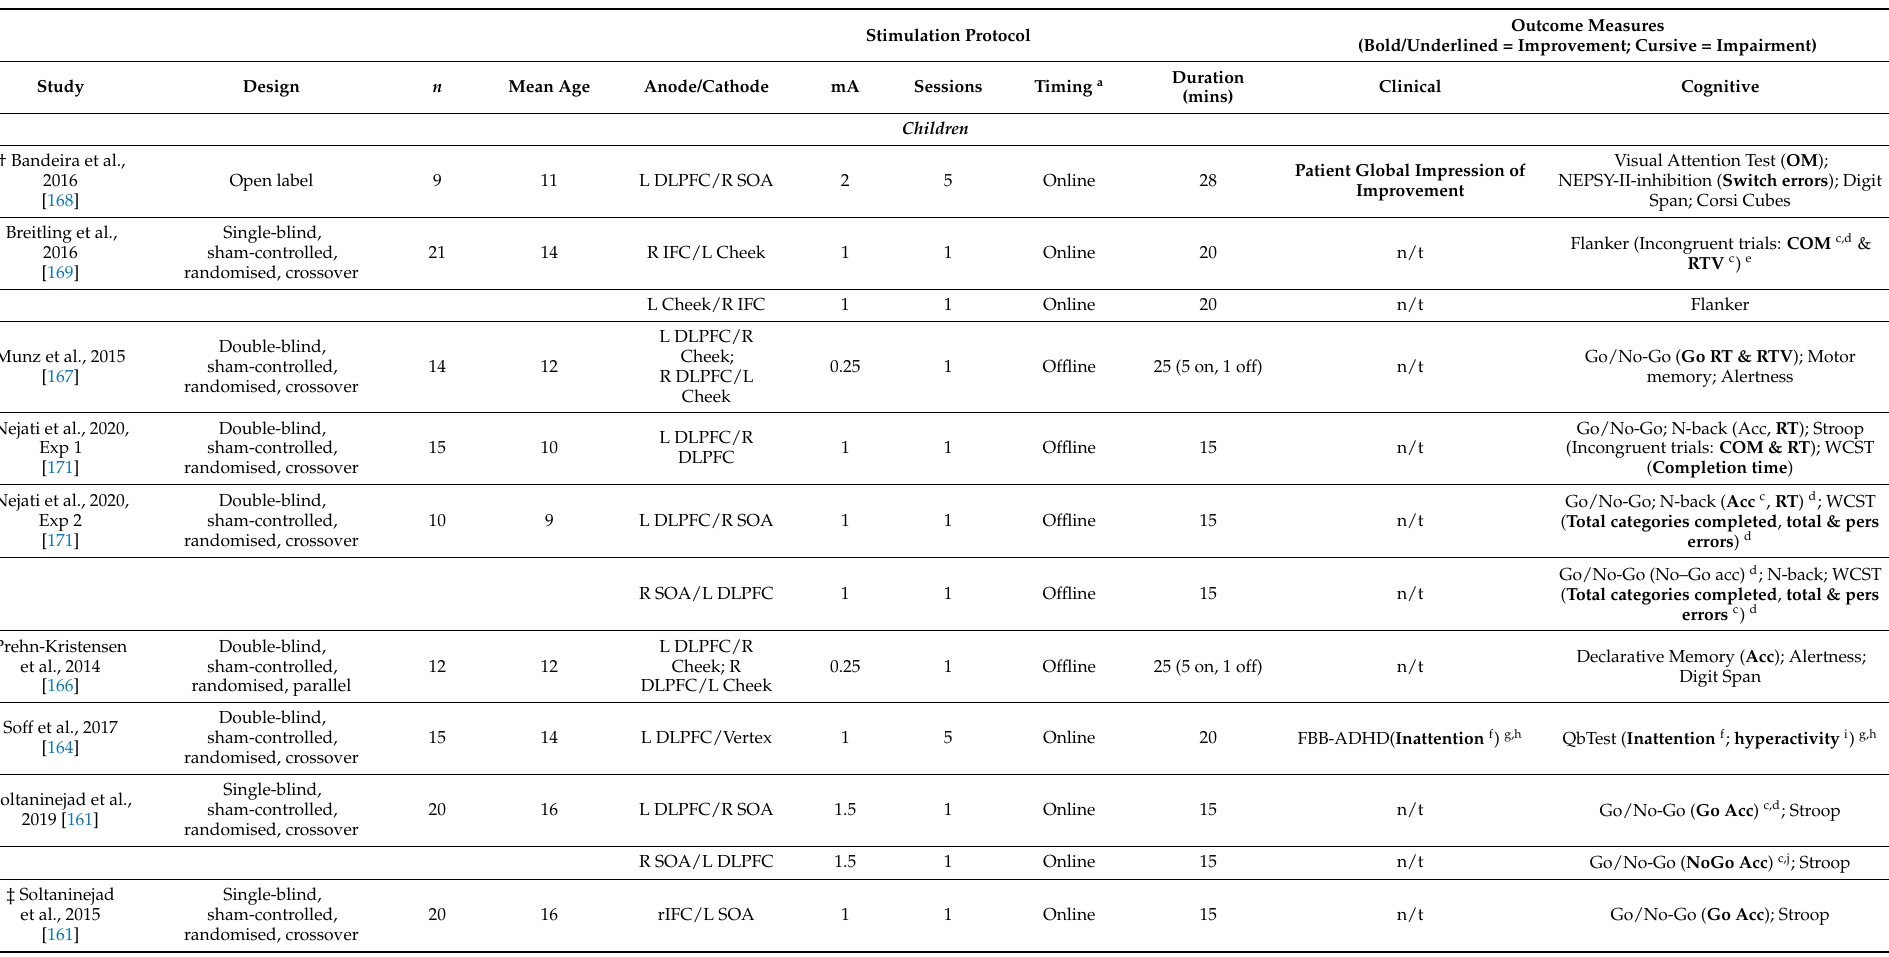
Table 2. Clinical and cognitive effects of sham-controlled tDCS